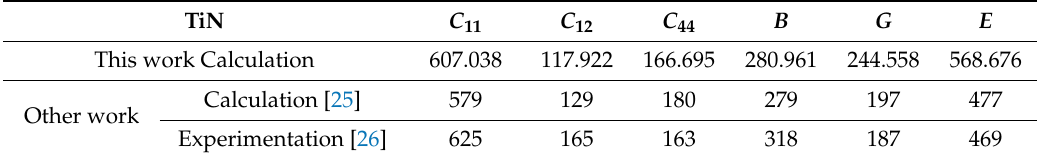
Table 1. Elastic constant of TiN.